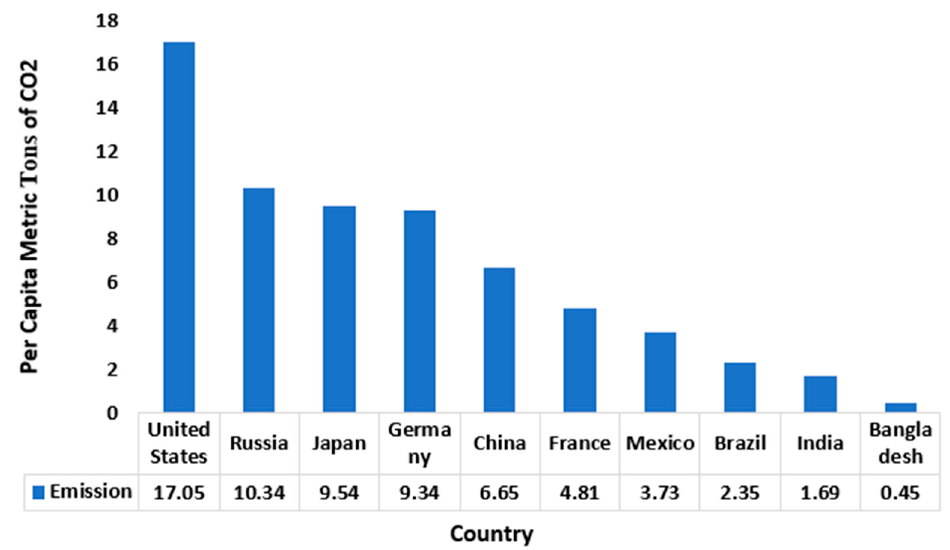
Figure 1. Comparison of emissions of CO 2 per capita in different nations [6].